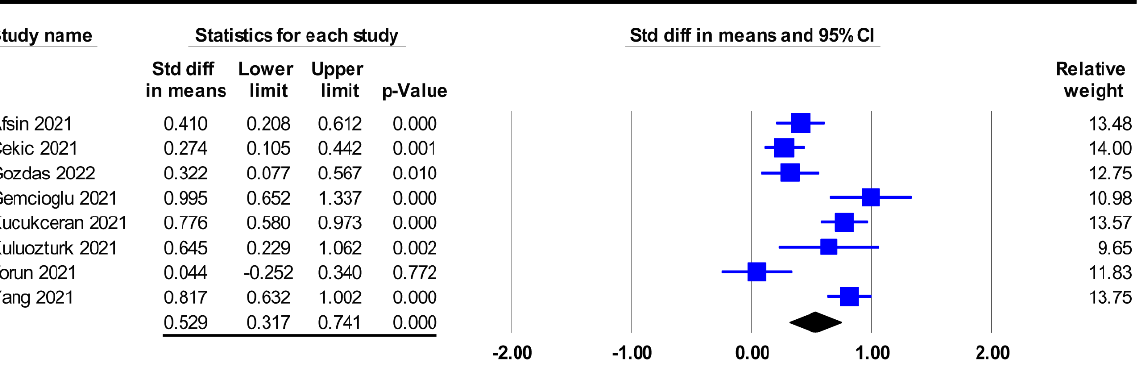
Figure 2. Risks of bias based on assessment with the Quality in Prognostic Studies (QUIPS) tool [12,24,25,32–38].